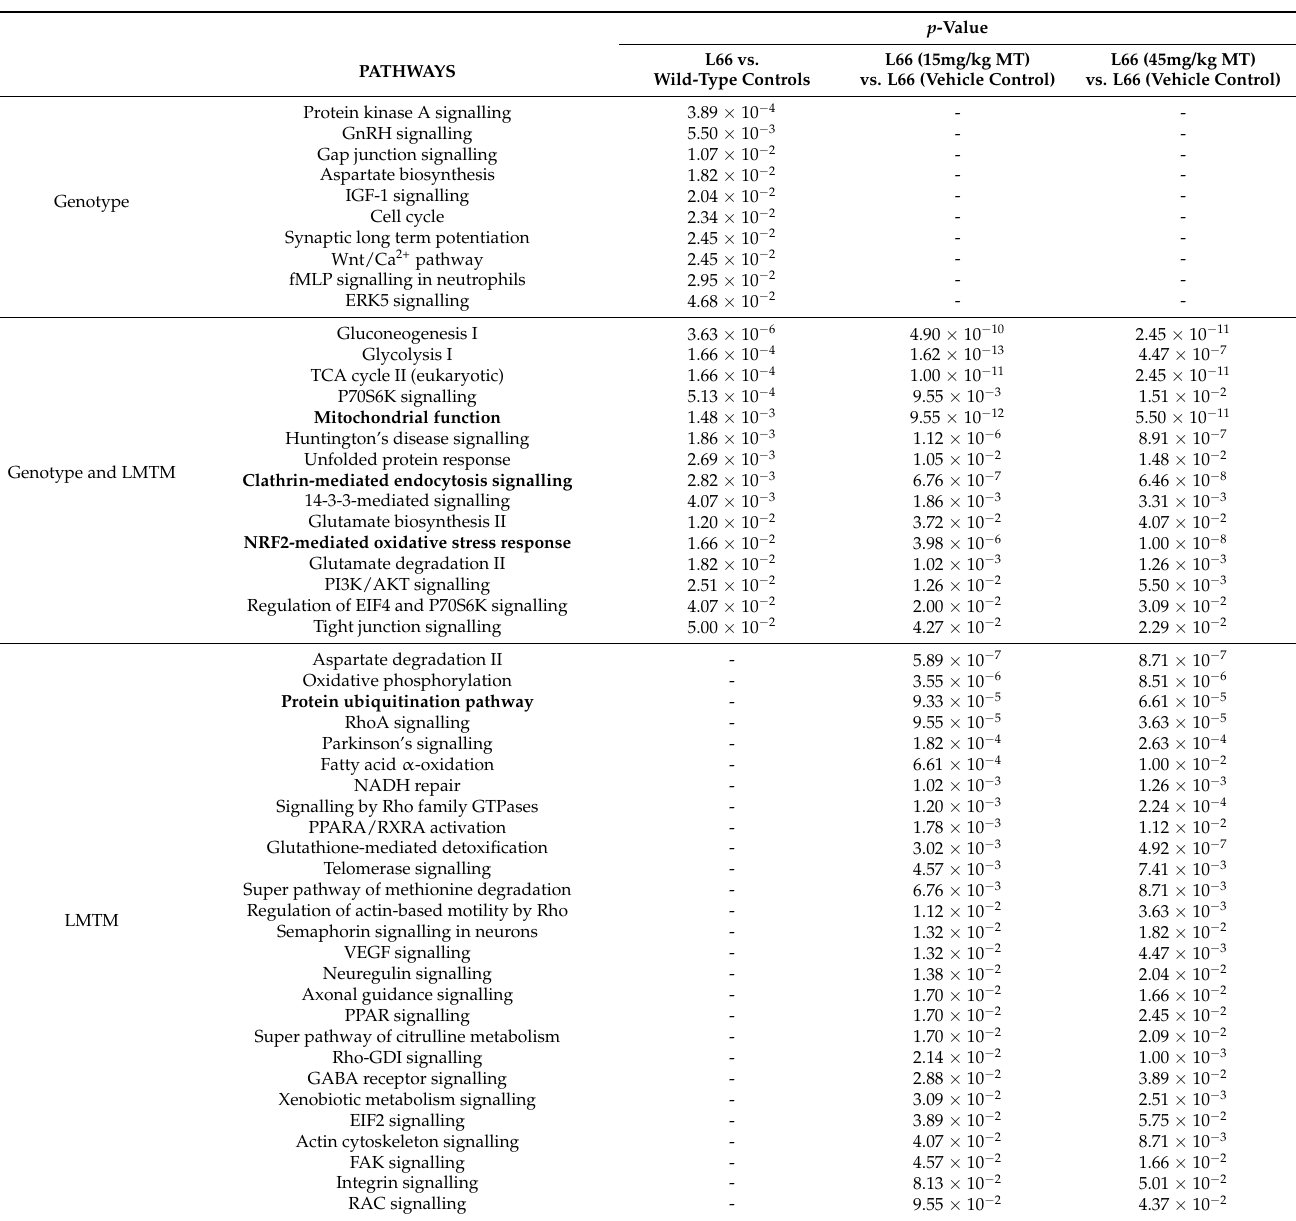
Table 2. Summary of significant hits for canonical pathways identified using IPA Core Analysis. The pathways are significantly altered due to tau overexpression, to LMTM treatment or both. Significant alterations were found by linking our proteomics data with the Ingenuity Knowledge Base. The pathways linked to protein changes are named and corresponding p -values are given. The highlighted pathways (bold) are of specific interest and are discussed in detail in the text and in Supplementary Figures